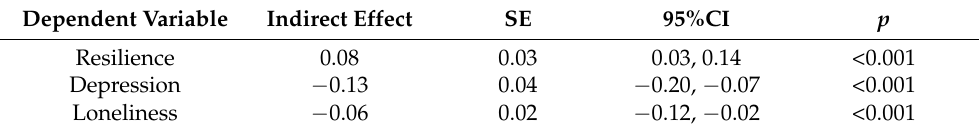
Table 2. Indirect effects between sense of control and the dependent variables ( n =